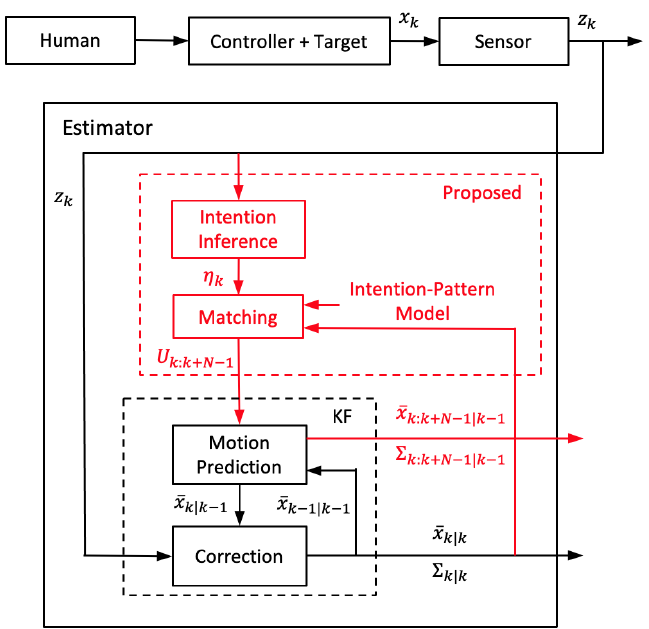
Figure 5. Estimation taking advantage of the proposed intention-pattern model. The red indicates the proposed parts compared with the conventional